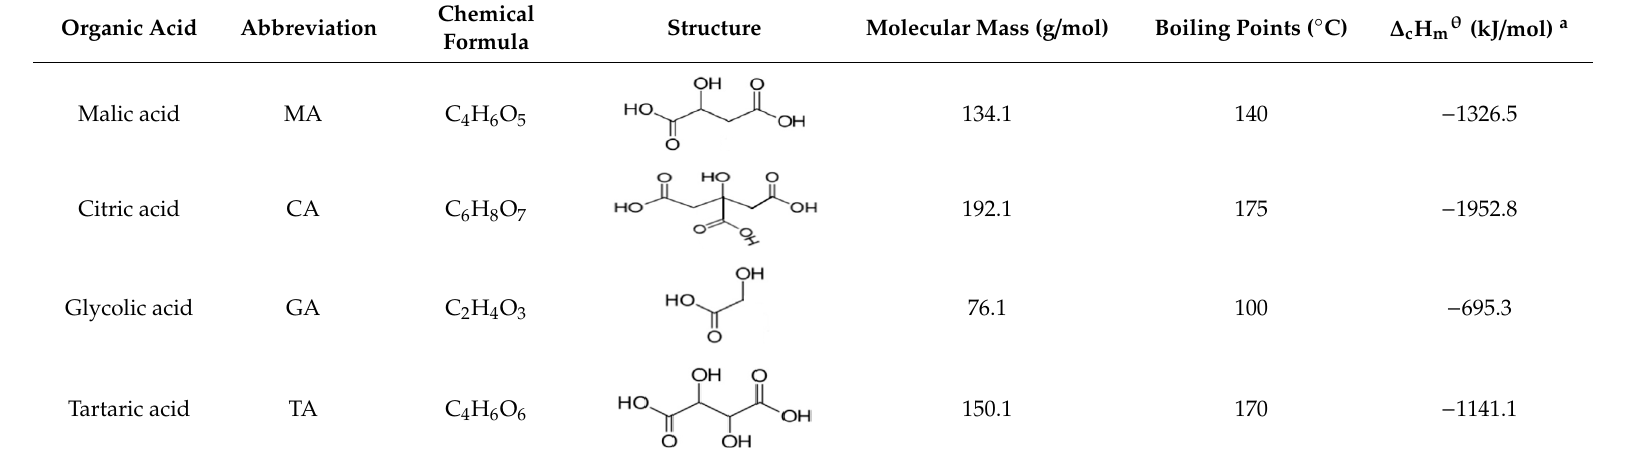
Table 1. The molecular structure and part of the physical properties of the organic acids selected.